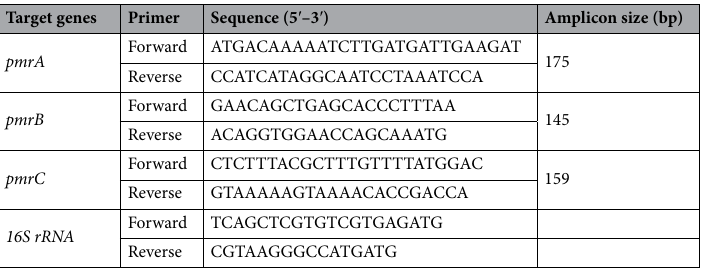
Table 1. Primer sequences used for the amplification of pmrA , pmrB, and